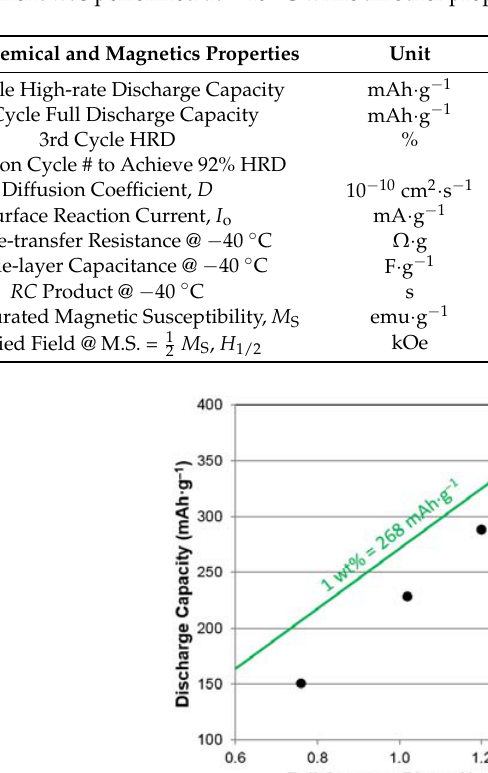
Table 7. Summary of electrochemical half-cell measurements: capacities at the 3rd cycle, HRD at the 3rd cycle, cycles needed to achieve 92% HRD, bulk diffusion coefficient, surface exchange current, and results from AC impedance and magnetic susceptibility measurements. AC impedance measurement was performed at − 40 ◦ C while all other properties were measured at room temperature.